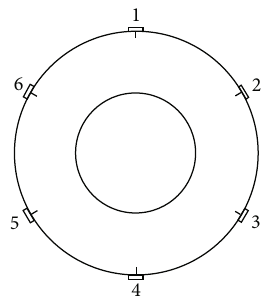
Figure 4: Measurement points sketch of the low-speed axial